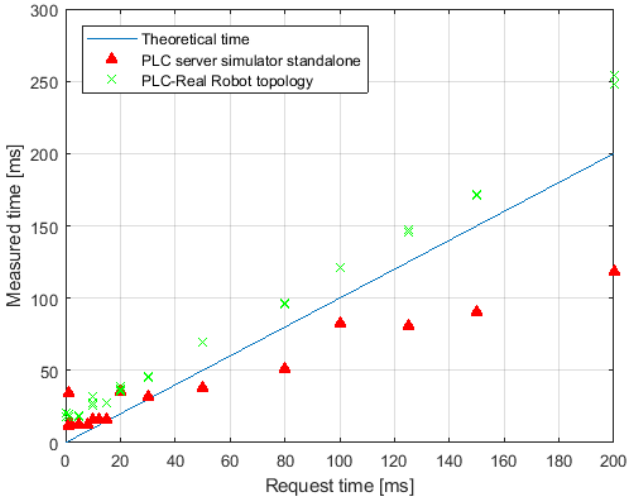
Figure 15. Overview of the actual responsiveness of different system